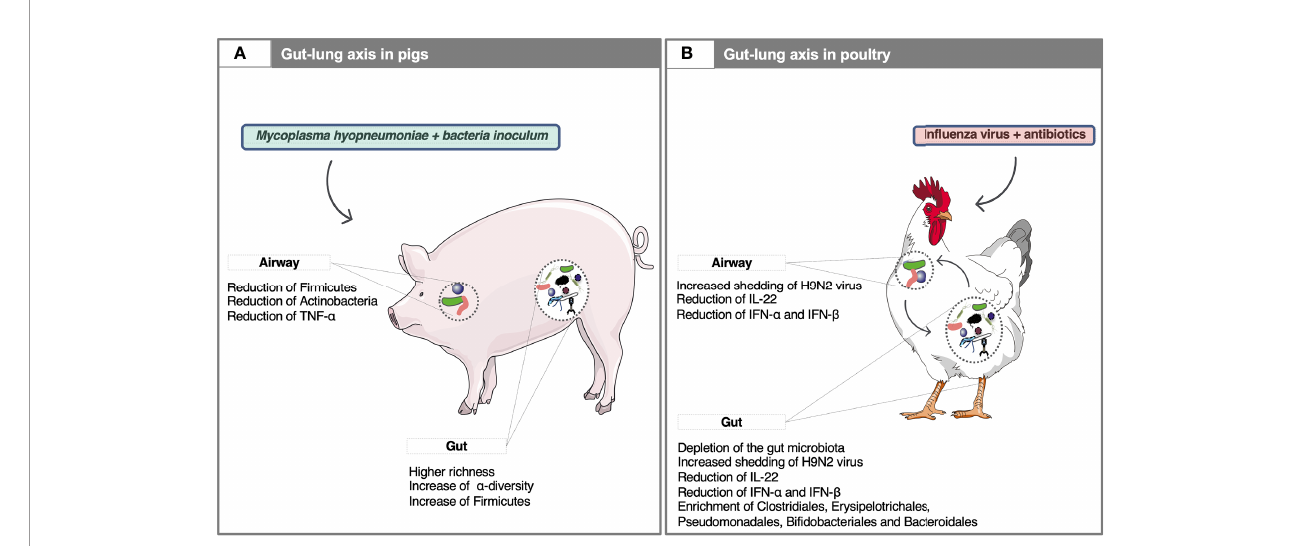
FIGURE 3 | Examples of the gut-lung axis cross-talk in domestic animals. (A) The gut microbiota composition affects systemic immune responses and lowers the severity of M. hyopneumoniae infection in the respiratory tract of pigs. For example, the administration of oral microbial inoculum increased Firmicutes such as Roseburia, Barnesiella, Blautia, Dorea in the gut and reduced the relative abundance of Actinobacteria and Firmicutes phyla in the airways microbiota, as well as the levels of TNF- a in the lungs and their lesions (Schachtschneider et al., 2013). Young pigs with low microbial diversity in the gut showed severe lung lesions on exposure to M. hyopneumoniae , whereas the opposite trend was observed in piglets with higher SCFA producing taxa in the gut ( e.g. , Ruminococcus , Prevotella , Ruminiclostridium , and Oscillospira ) (Surendran Nair et al., 2019). In addition to having local effects in the gut, SCFAs enter the circulation, modulate bone-marrow hematopoiesis and thereby can promote regulatory or pro-in fl ammatory responses in the lung (Surendran Nair et al., 2019); (B) In H9N2 subtype LPAIV infected chickens, microbiota gut depletion using antibiotics have shown to reduce IFN response, which plays an important role in innate responses to viral infections in the gut and airways and increase the in fl uenza virus shedding from the upper respiratory and gastrointestinal tracts (Yitbarek et al., 2018a). Along with IFNs, treatment of chickens with antibiotics for 12 days resulted in reduced interleukin 22 expression in the respiratory tract after gut microbiota depletion and in enrichment with class Erysipelotrichia, Bacteroidia and with order Clostridiales, Erysipelotrichales, Pseudomonadales, Bi fi dobacteriales and Bacteroidales (Yitbarek et al., 2018b). Written permission for publication of the chicken drawing in the fi gure has been taken. The pictures of the pig, bacteria and viruses were downloaded from smart Servier Medical Art https://smart.servier.com without changes. Servier Medical Art by Servier is licensed under a Creative Commons Attribution 3.0